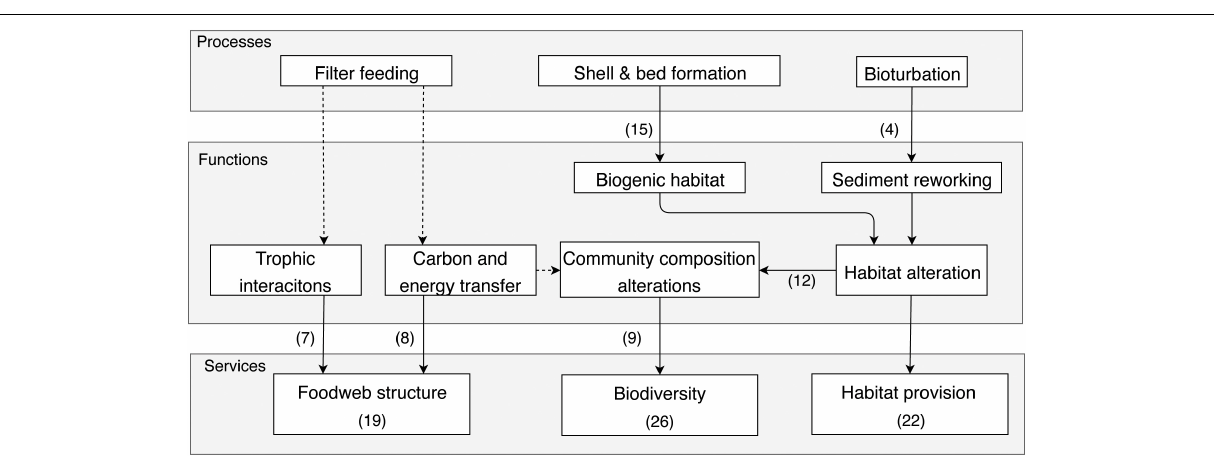
FIGURE 6 | Simplified cascade showing the links between processes, functions, and services in the Biological structuring bundle. The number of papers discussing a service is indicated in brackets within the service box, while the number of times links between processes and functions were discussed is indicated in brackets next to the arrows. Dashed lines indicate links that are inferred from expert